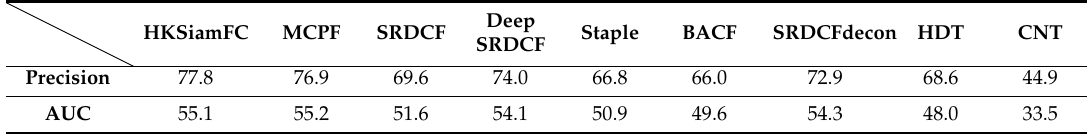
Table 3. Precision and Area Under Curve (AUC) value of the HKSiamFC and eight other trackers on the TC128 dataset(The first and second best scores are marked with red and green colors, respectively).